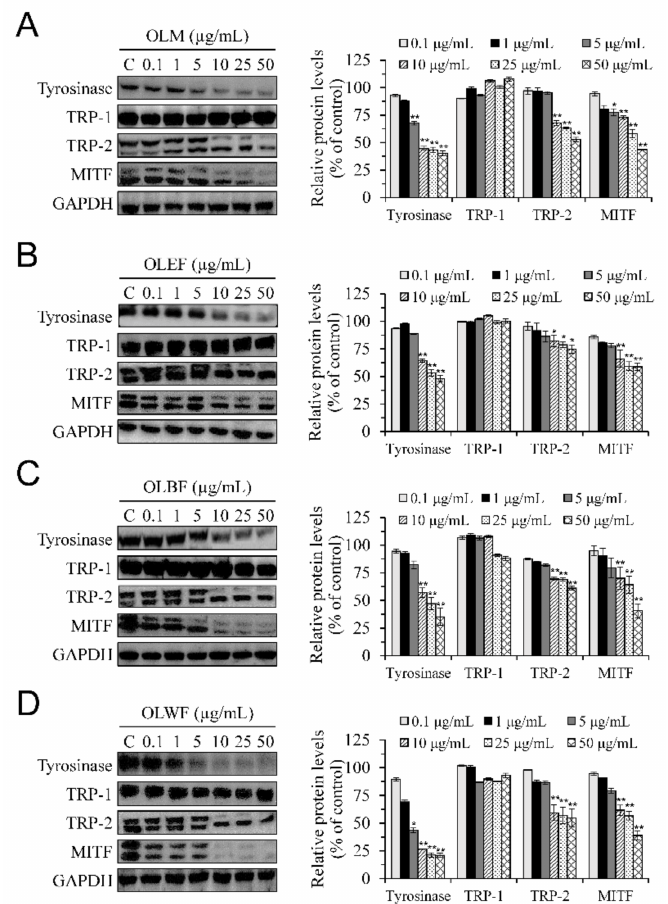
Figure 4. The effects of OLM ( A ) and its fractions, including OLEF ( B ), OLBF ( C ), and OLWF ( D ), on protein expressions of tyrosinase, TRP-1, TRP-2, and MITF in B16-F10 cells. B16-F10 melanoma cells were treated with test samples for 48 h at concentrations up to 50 µ g/mL, known to be non-toxic. Left panels, representative immunoblots. Right panels, densitometry analyses of the relative ratio of protein/GAPDH protein, represented as percentages of the control group. Columns, mean ± SD of three independent experiments. * p < 0.05, ** p < 0.01, compared with control